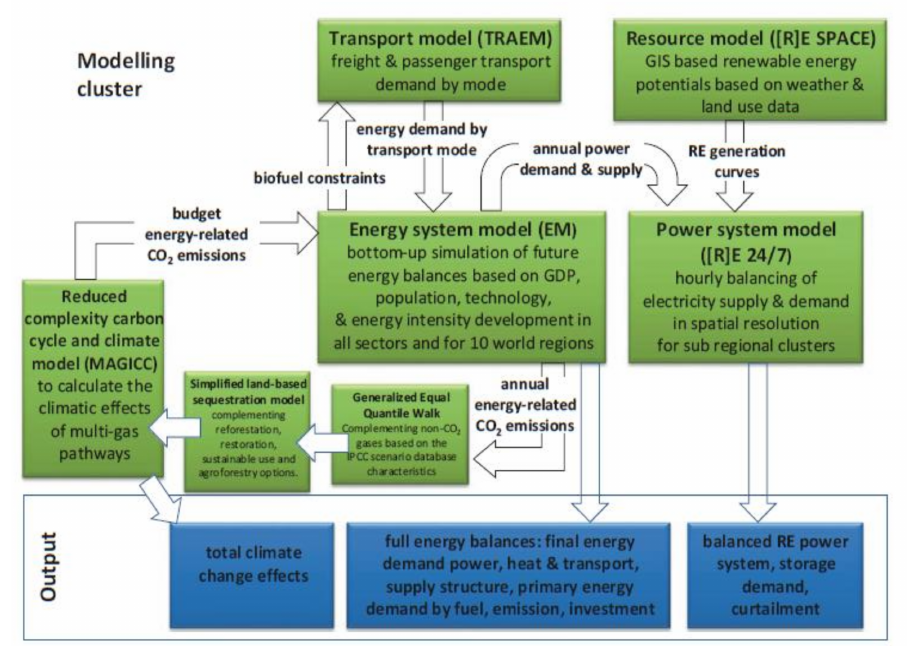
Figure 6. Interaction of the models used in this